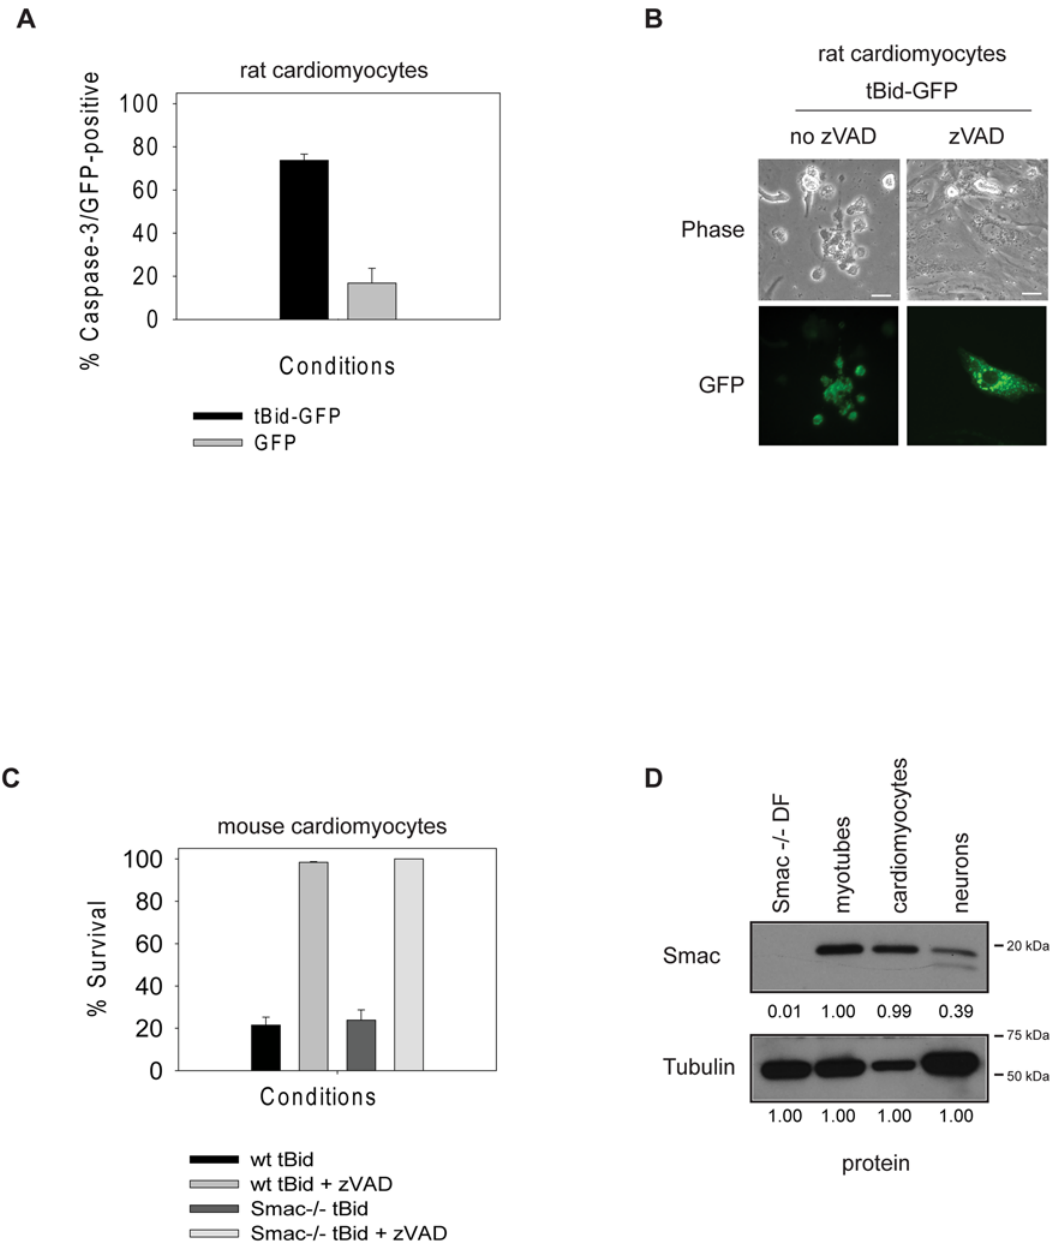
Figure 5. tBid induced apoptosis in cardiomyocytes does not require endogenous Smac. (A) Rat cardiomyocytes were transfected with tBid-GFP or GFP alone. The percentage of transfected cells expressing active caspase 3 was determined 6 hours after transfection by immunohistochemistry. (B) Photographs of rat cardiomyocytes 6 hours after transfection with tBid-GFP in the presence or absence of the caspase inhibitor z-VAD-fmk (zVAD). (C) Wild type (wt) or Smac-deficient (Smac-/-) cardiomyocytes were infected with a tBid-GFP adenovirus in the presence or absence of z-VAD-fmk (zVAD). Cell survival was determined by morphology over a 12 hour period using time-lapse microscopy. (D) Protein levels of Smac were examined by Western blot of whole cell lysates from Smac-deficient dermal fibroblasts (Smac-/- DF), myotubes, cardiomyocytes and sympathetic neurons (neurons). Tubulin serves as a loading control. Densitometry of Smac protein levels are normalized to tubulin levels of the representative